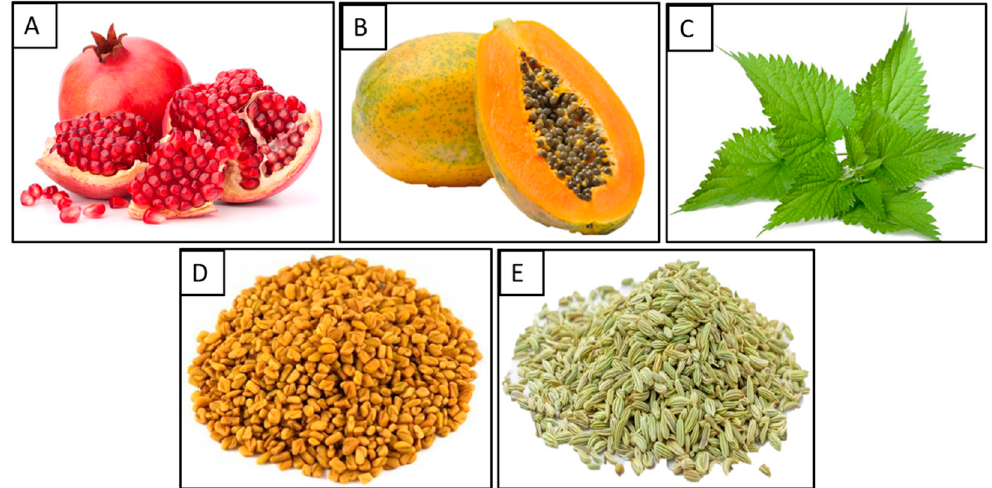
Figure 1. Different nutraceuticals used in this study. ( A ) Punica granatum , ( B ) Carica papaya , ( C ) Ur- tica dioica , ( D ) Trigonella foenum-graecum , and ( E ) Foeniculum vulgare . dioica , ( D ) Trigonella foenum-graecum , and ( E ) Foeniculum vulgare